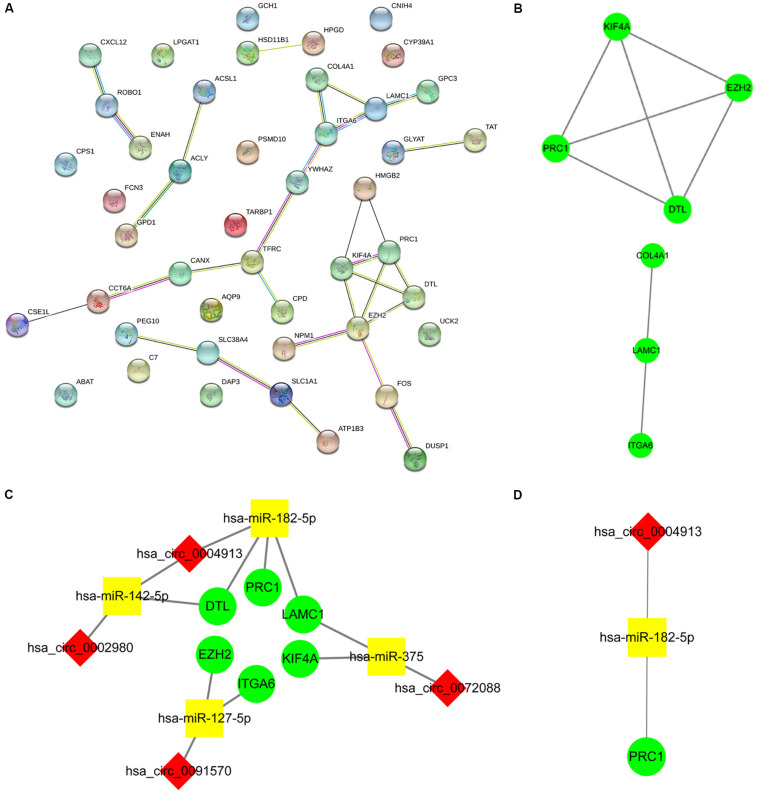
Construction of the hub circRNA-miRNA-mRNA network. (A) PPI network analysis of 45 DEmRNAs related to macrophage. (B) Two subnetworks of PPI network analyzed by the MCODE plugin of cytoscape. (C) Construction of the circRNA-miRNA-mRNA network based on six hub DEmRNAs related to macrophages. (D) Construction of the circRNA-miRNA-mRNA network based on PRC1. PRC1 was identified as the most influential node by the IVI method. The red diamond, yellow rectangle, and light green ellipse indicate circRNA, miRNA, and mRNA, respectively.